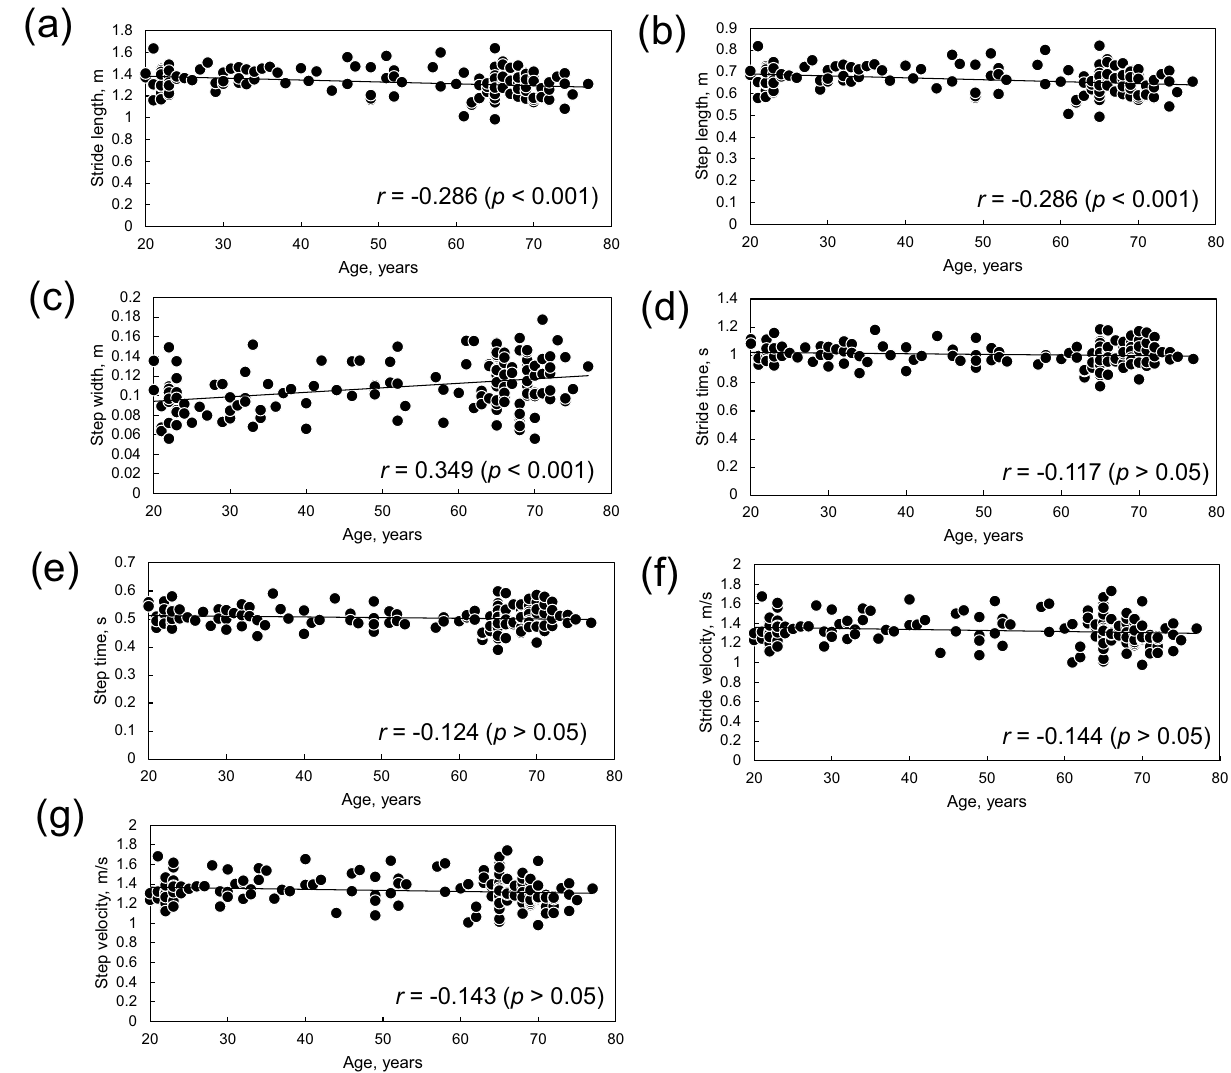
Figure 1. Relation between age and ( a ) stride length, ( b ) step length, ( c ) step width, ( d ) stride time, ( e ) step time, ( f ) stride velocity, and ( g ) step